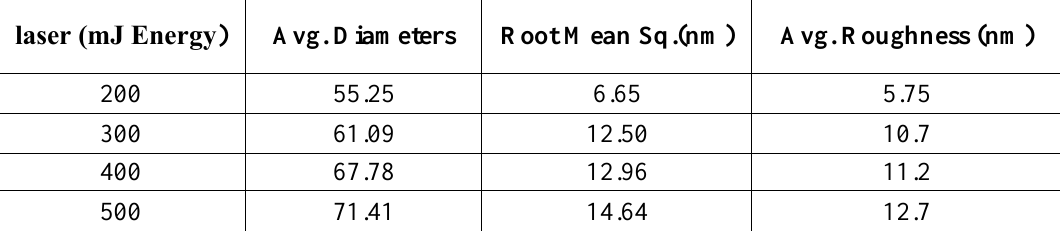
Table 2: AFM parameters (Average Diameters, RMS and Average Roughness) for CdO:CoO thin films at different